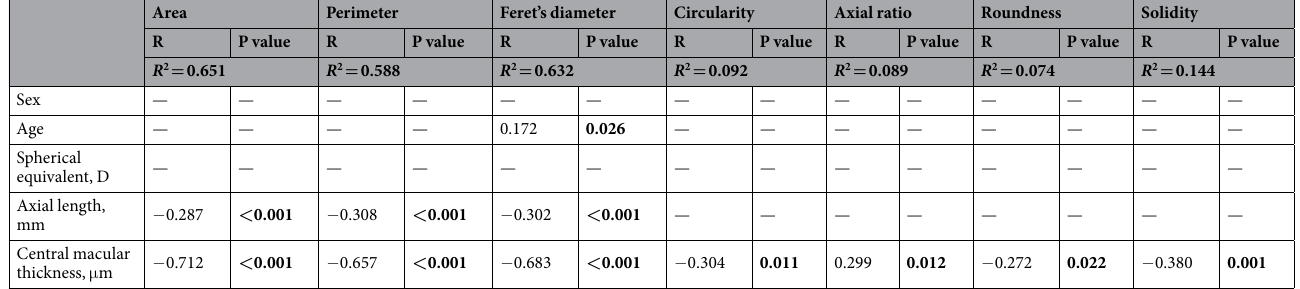
Table 5. Multiple linear regression analysis of factors affecting each